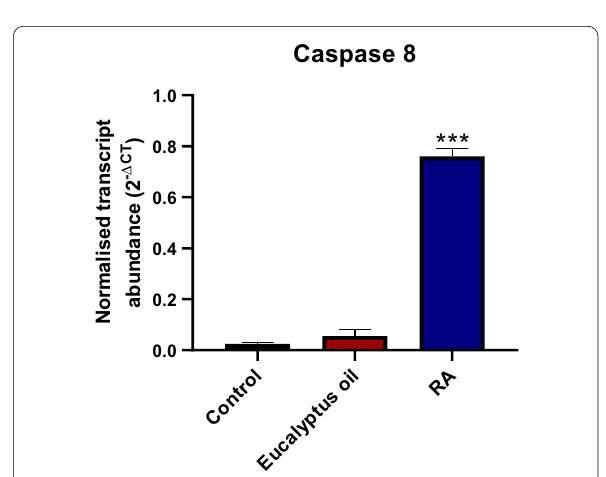
Fig. 6 Effect of EU and RA on gene expression levels for